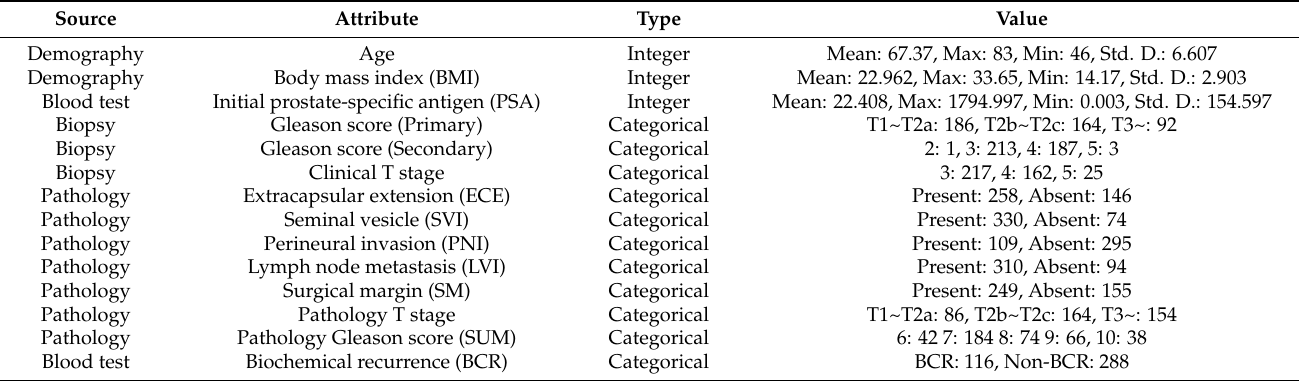
Table 1. Collected data of 404 PCa patients from a CDW.